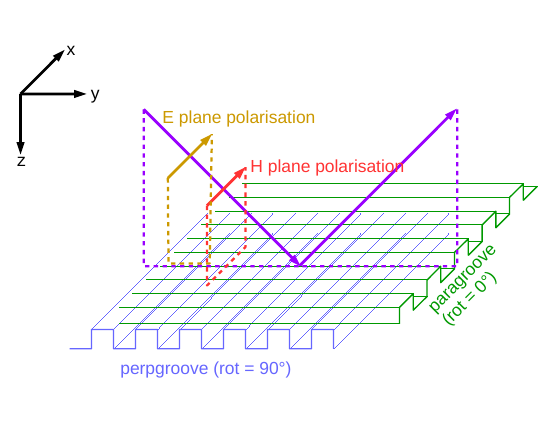
Figure 2. Side view of the optimised polariser profile “E8_4” with period p = 1 . 07mm and ridge height t = 415 µ m. The equivalent rectangular groove parameters are reduced depth t and groove width c (second line).